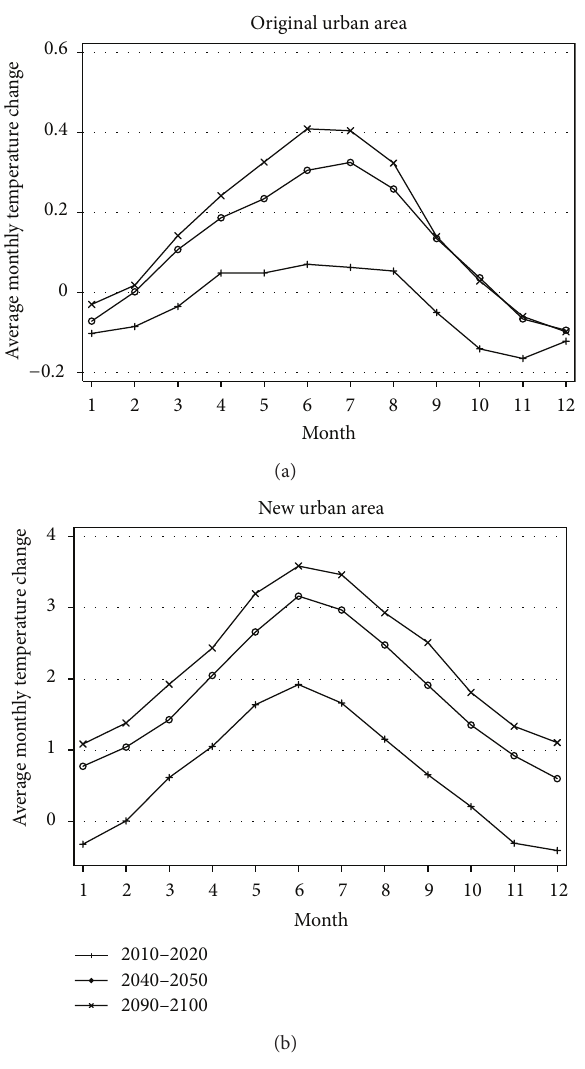
Figure 5: Effects of future urban expansion on average monthly temperature in urban area in the Northeast megalopolis, USA (unit: ∘ C).